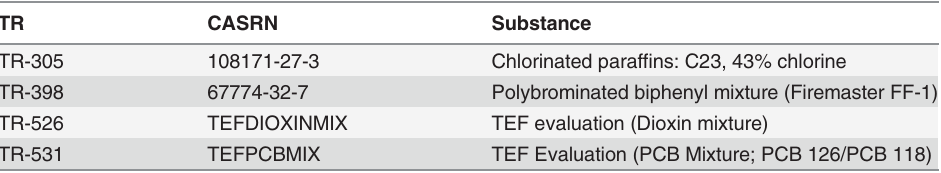
Table 2. List of 2Y-CSs on mixtures that were included in the analysis. TR CASRN Substance TR-305 108171-27-3 TR-398 67774-32-7 Polybrominated biphenyl mixture (Firemaster FF-1) TR-526 TEFDIOXINMIX TEF evaluation (Dioxin mixture) TR-531 TEFPCBMIX TEF Evaluation (PCB Mixture; PCB 126/PCB 118)